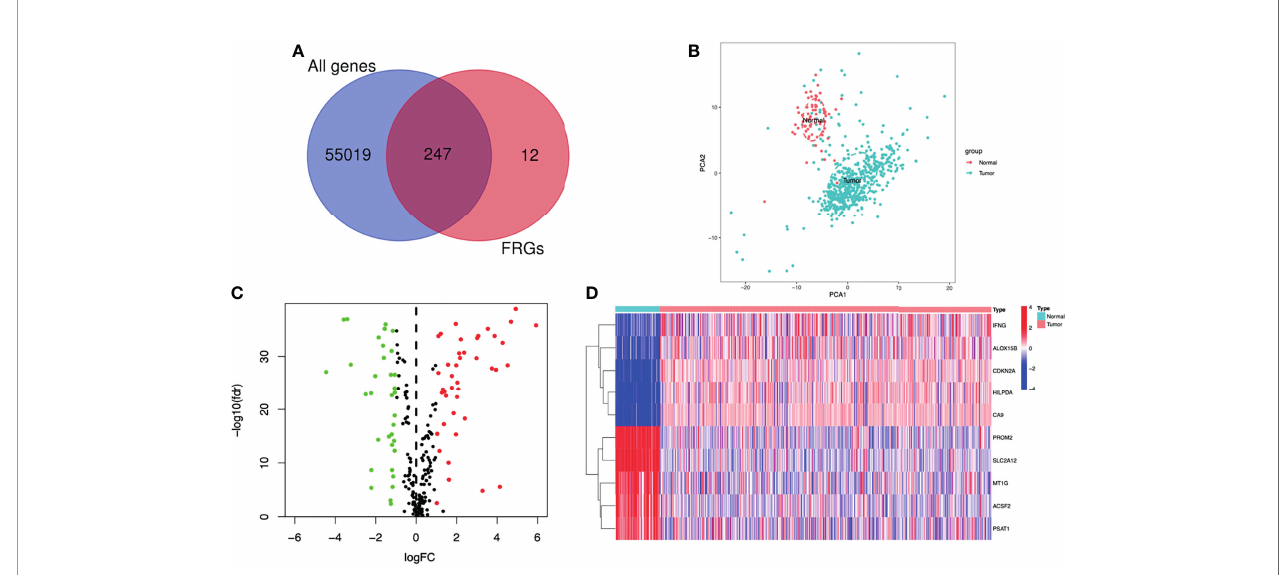
FIGURE 2 | Screening of the DE-FRGs. (A) The FRGs expressed between ccRCC specimens and normal specimens. (B) A PCA plot of the expression pro fi le of FRGs between tumor and normal specimens. (C) Volcano plot of DE-FRGs between tumor and normal specimens. The green dots represent DE-FRGs with log2FC < -1 and the red dots represent DE-FRGs with Log2FC > 1. (D) Heatmap of the top 5 up- and down-regulated FRGs. DE-FRGs, differentially expressed FRGs; PCA, Principal component